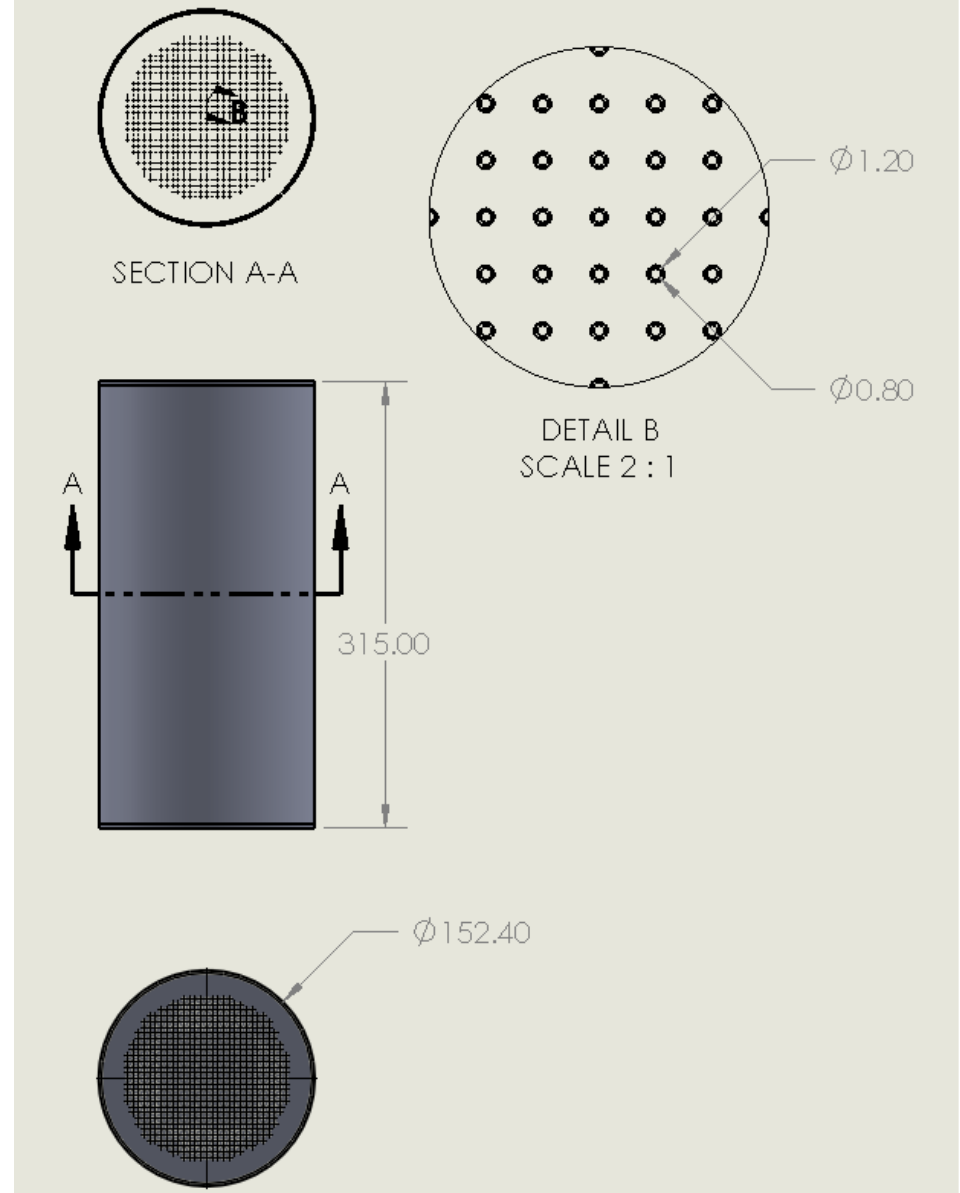
Figure 2. CAD drawing of tube heat exchanger (dimensions in mm) [10].